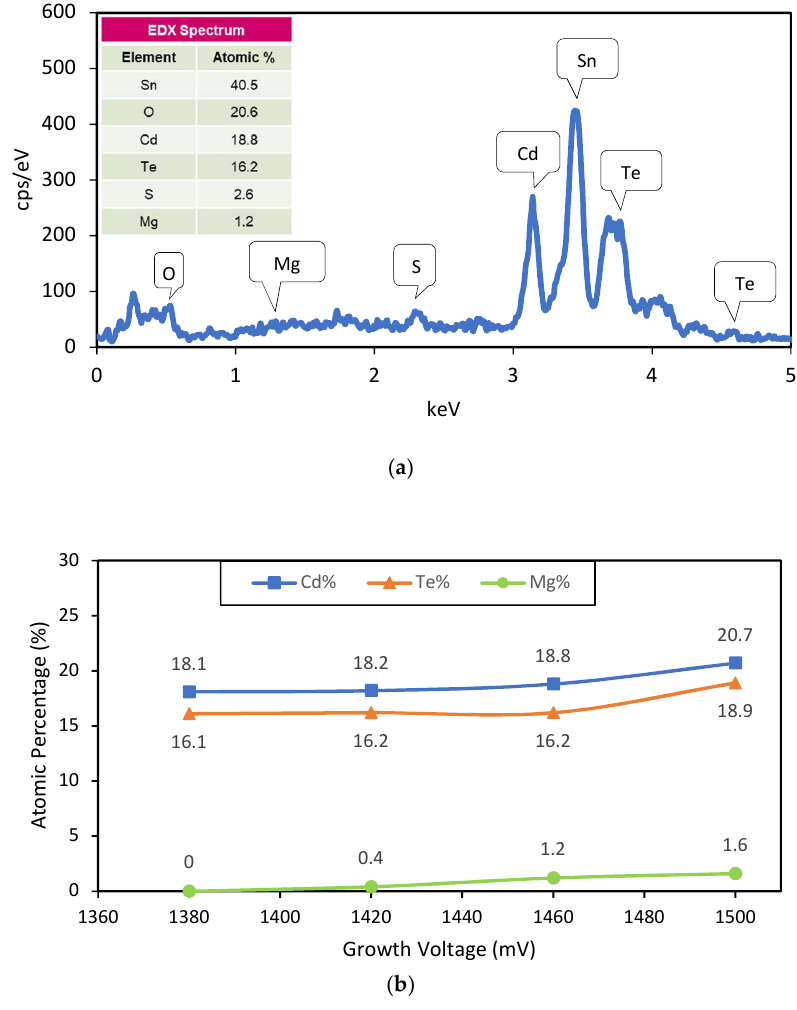
Figure 2. ( a ) A typical EDX spectrum of an as-deposited CdTe:Mg grown at 1460 mV with high Mg presence in the bath and ( b ) gradual inclusion of Mg in the Cd-rich CdTe with increasing growth voltage.